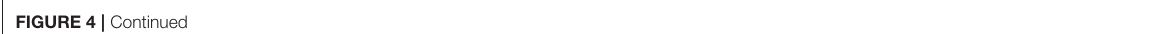
FIGURE 4 | Continued Results, expressed as fold change vs. VSMCs from LZR, are mean ± standard error of the mean ( n = 6). * p < 0.05, MSZR vs. LZR. (E) Representative images of gelatinolytic metalloproteinase activity in the aorta was measured using in situ gelatin zymography for each group of Zucker rats. Fluorescence as marker for intra-plaque gelatinolytic activity was quantified. Nuclei were visualized by DAPI staining. (F) Average wall fluorescence of the gelatinolytic metalloproteinase activity in the aorta. (G) Representative images of zymography gels of LZR and MSZR VSCMCs supernatant at 4, 8, and 20h. (H) Relative MMP-2 activity in LZR and MSZR VSMC supernatant at 4, 8, and 20h. Results are mean ± standard error of the mean ( n = 5). * p < 0.05, MSZR vs. LZR. ELISAs results of MMP-9 (I) and VCAM-1 (J) measured in PFP ( n = 17–22). * p < 0.05 vs. LZR at the same age; # p < 0.05 vs. 25 week-old rats in the same